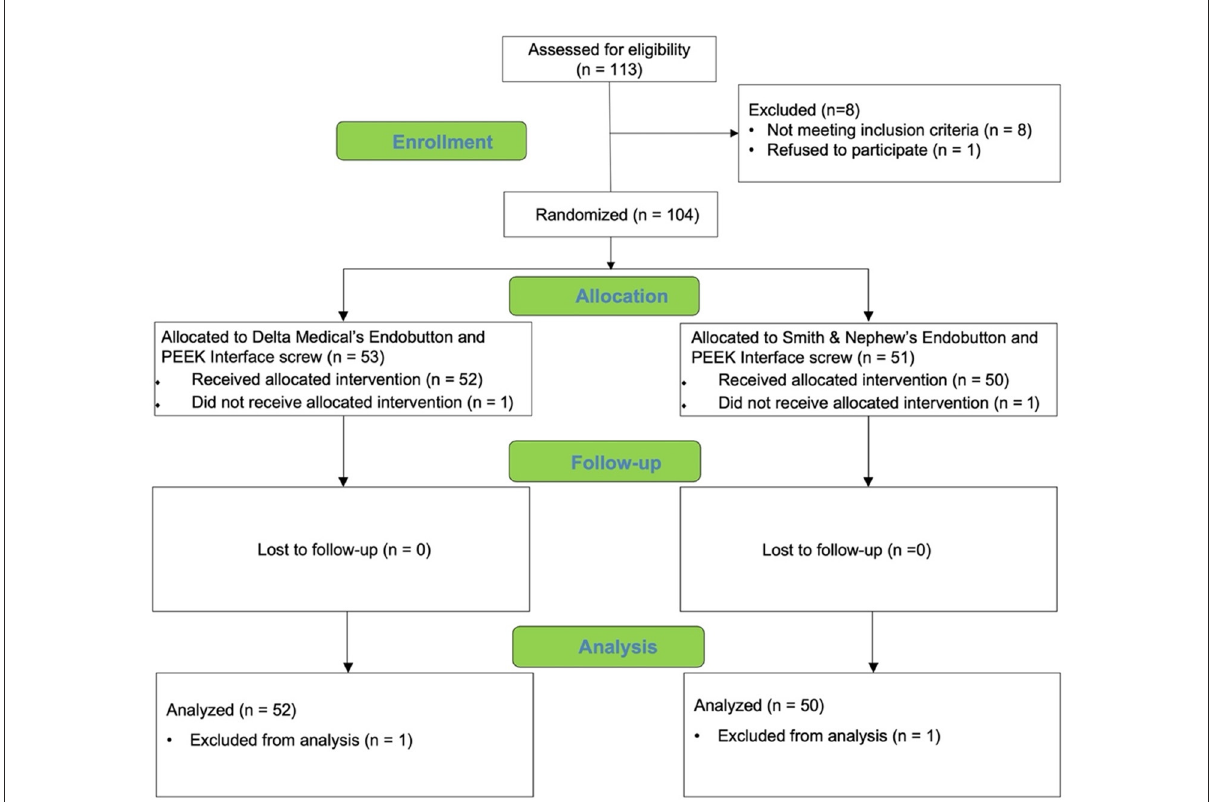
FIGURE3 CONSORT (Consolidated Standards of Reporting Trials) flow diagram.